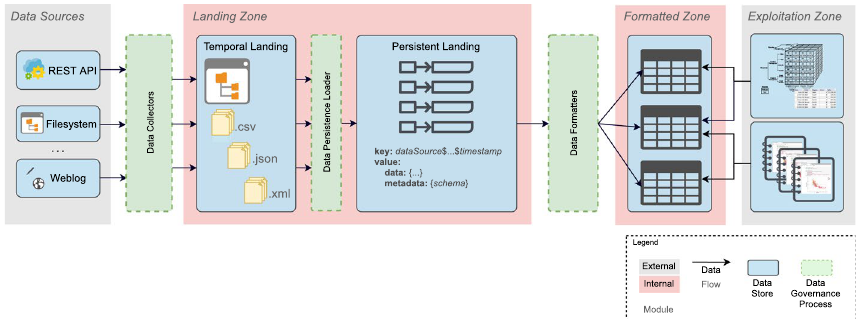
Fig. 3 High-level overview of the proposed Data Lake architecture and its